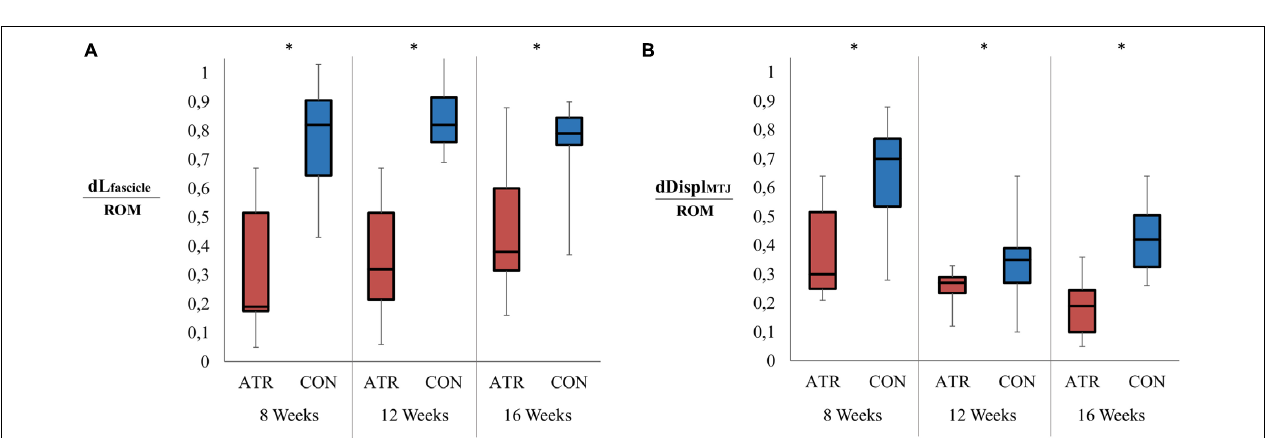
FIGURE 4 | Ranges in relevant muscle-tendon unit architecture parameters between maximal plantarflexion and maximal dorsiflexion, normalized to the overall ankle range of motion (ROM). Significant levels for the effect of leg type [as determined by a factorial repeated-measures ANOVA ( p < 0.01)] are indicated with *. (A) Relative change in the medial gastrocnemius fascicle length (mm) as normalized to the ankle range of motion ( ◦ ). (B) Displacement of the musculotendinous junction (MTJ, in mm) as normalized to the ankle range of motion ( ◦